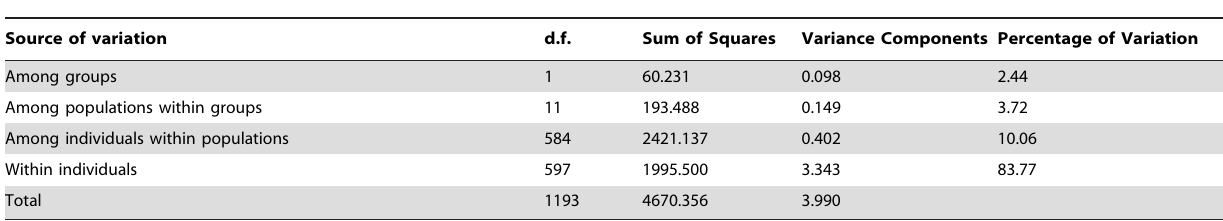
Table 4. Analysis of Molecular Variance (AMOVA) results when populations are grouped by East or West side of Rocky Mountains.